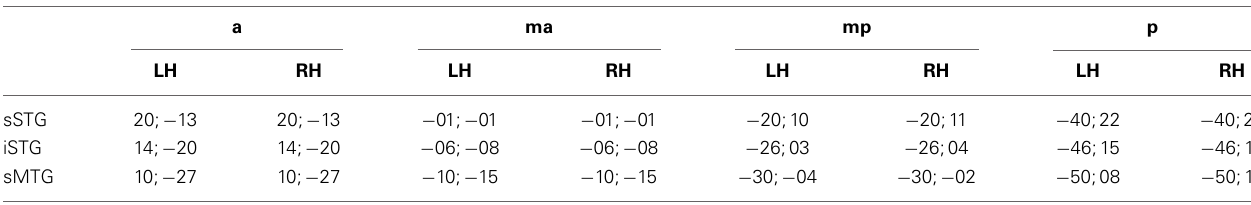
Table 2 | Position of the regions of interest in Talairach